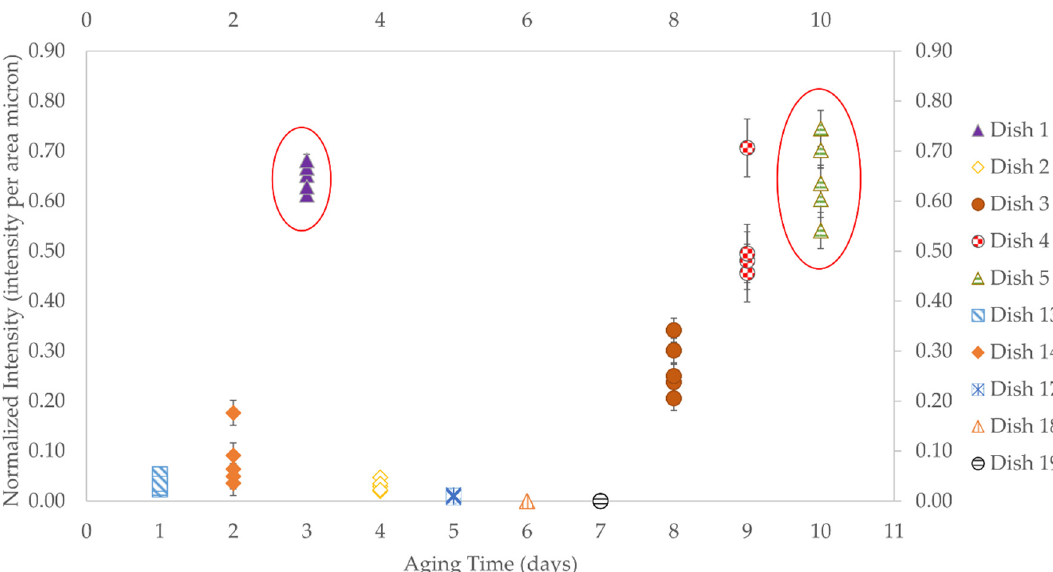
Figure 7. Normalized intensity vs. aging time. Each analyzed day includes a Petri dish that contains five coated microspheres. Day 3 and Day 10 shows the optimum results for MIPs coating procedure. Day 3 was chosen as it resulted in a more consistent normalized intensity and a shorter time-frame.